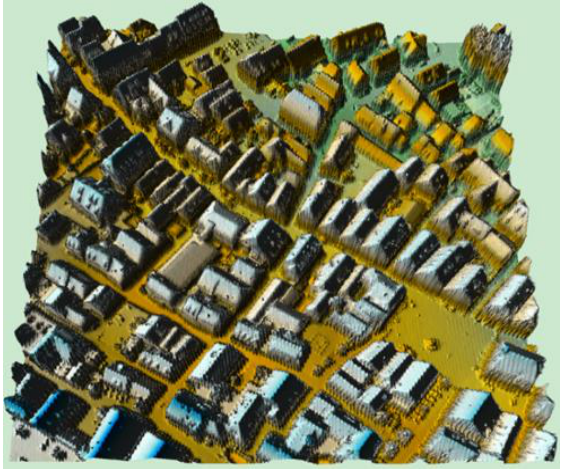
Fig.8 The DSM from the LiDAR data in Vaihingen